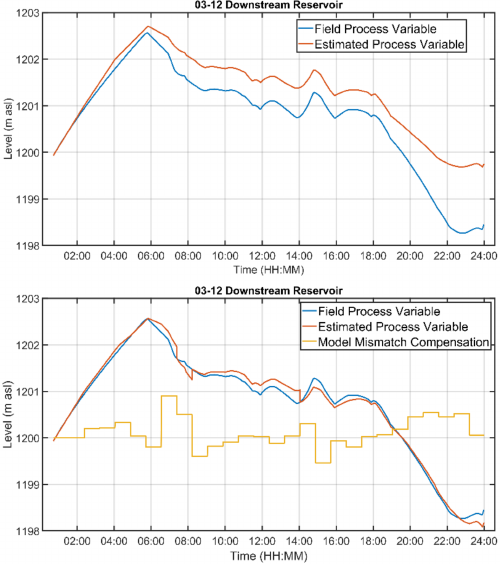
Figure 15. Model mismatch compensation results: downstream reservoir level with and without model mismatch